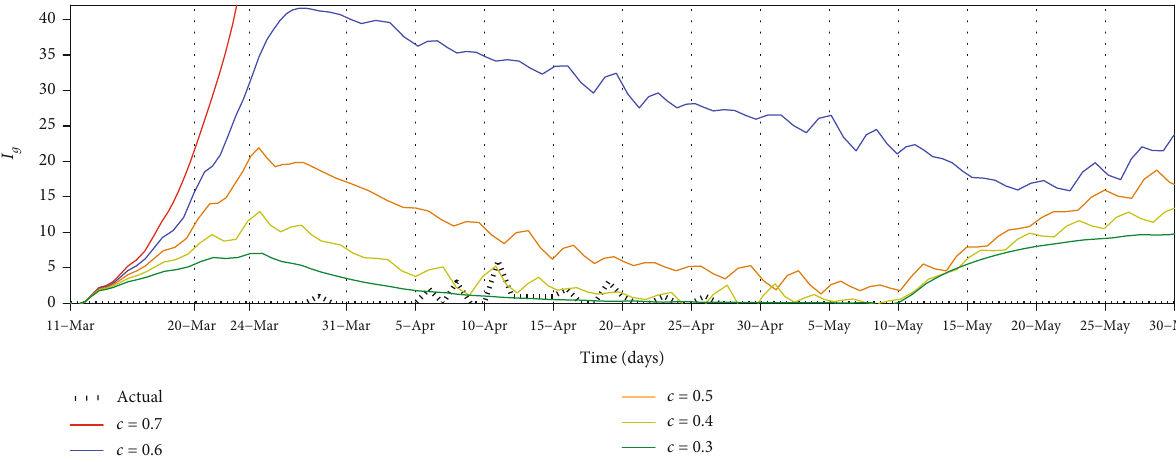
Figure 5: Comparison of actual infected data and simulation results for di ff erent contact rate values in Gampaha district.